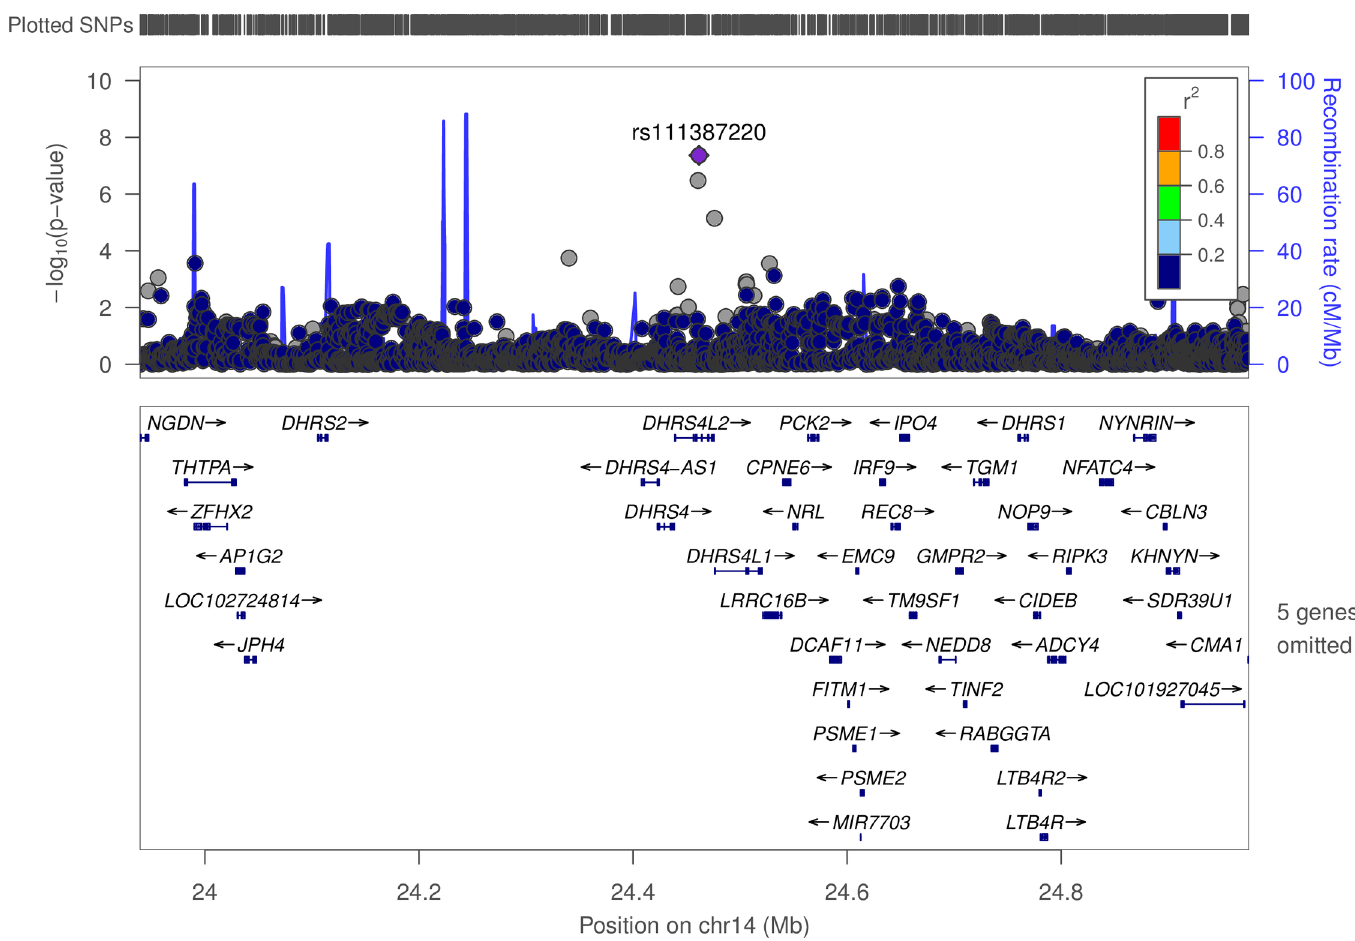
Fig 4. LD structure for variants associated with D9D_16_18 in and near DHRS4L2 .